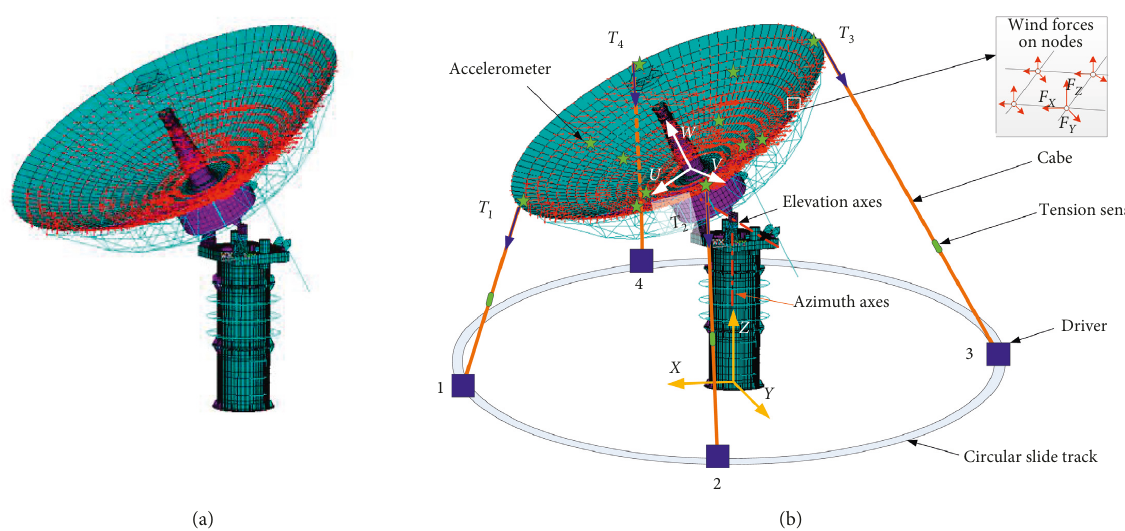
Figure 1: Schematic diagram of a large antenna under wind disturbance. (a) Original structure. (b) Original structure equipped with the adaptive